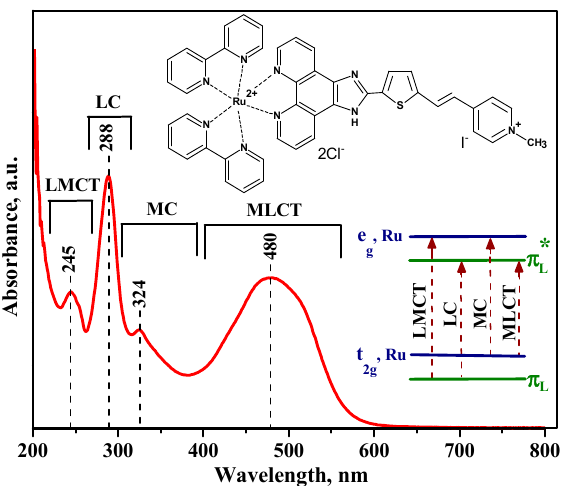
Figure 4. UV-Vis absorption spectra of the Ru (II) heterocyclic complex in methanol solution (C = 5 × 10 − 5 М ). The inset shows the four possible transitions, labeled according to the involved molecular orbitals.